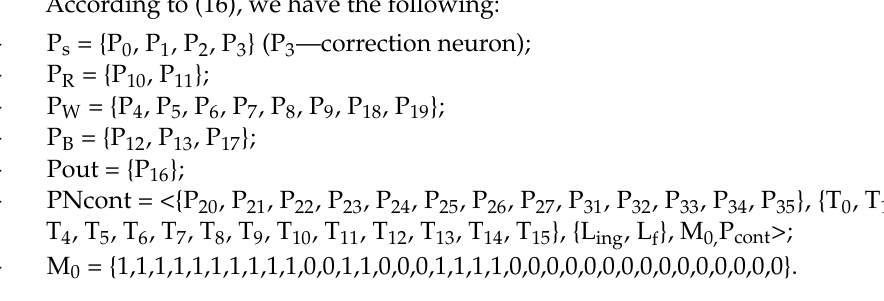
Figure 5. Example model of an artificial neural network based on Petri nets.